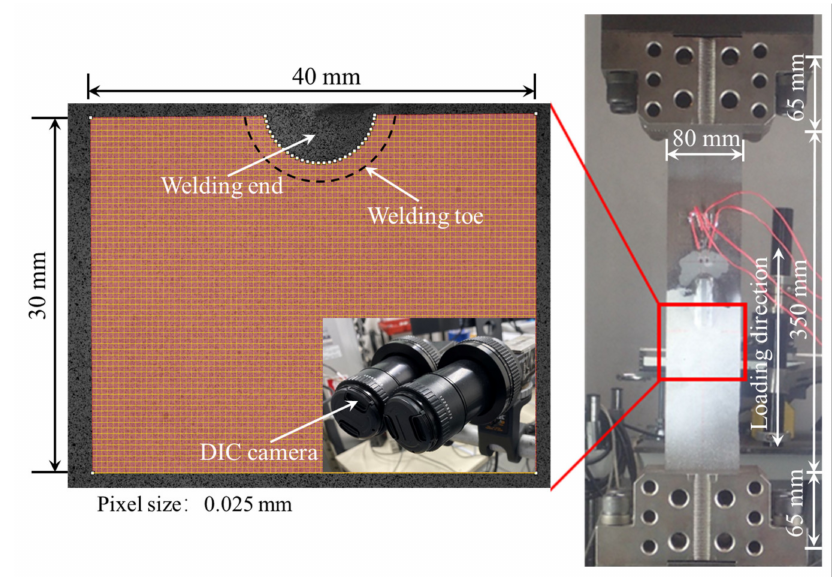
Figure 5. The DIC setup and loading conditions.